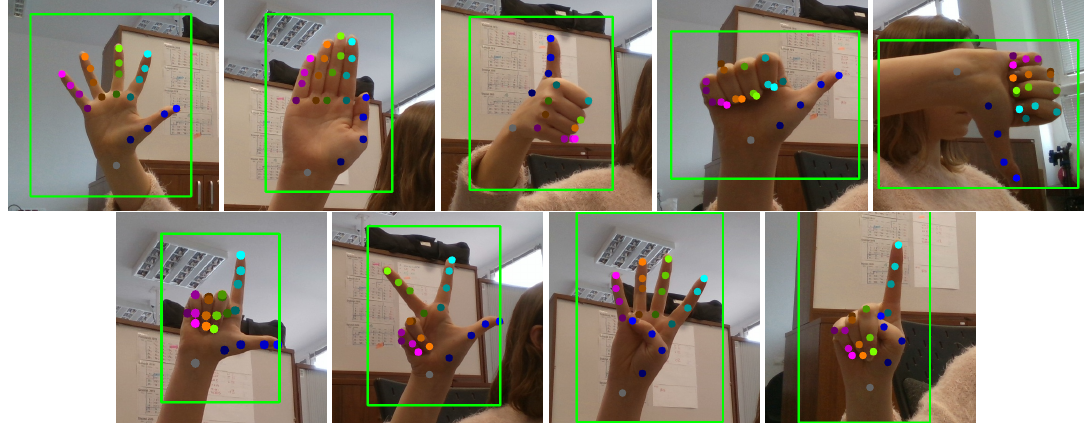
Figure 27. Set of nine gestures used for the joint-based experiments. Coloured dots represent estimated joints positions, calculated with the 3DHand